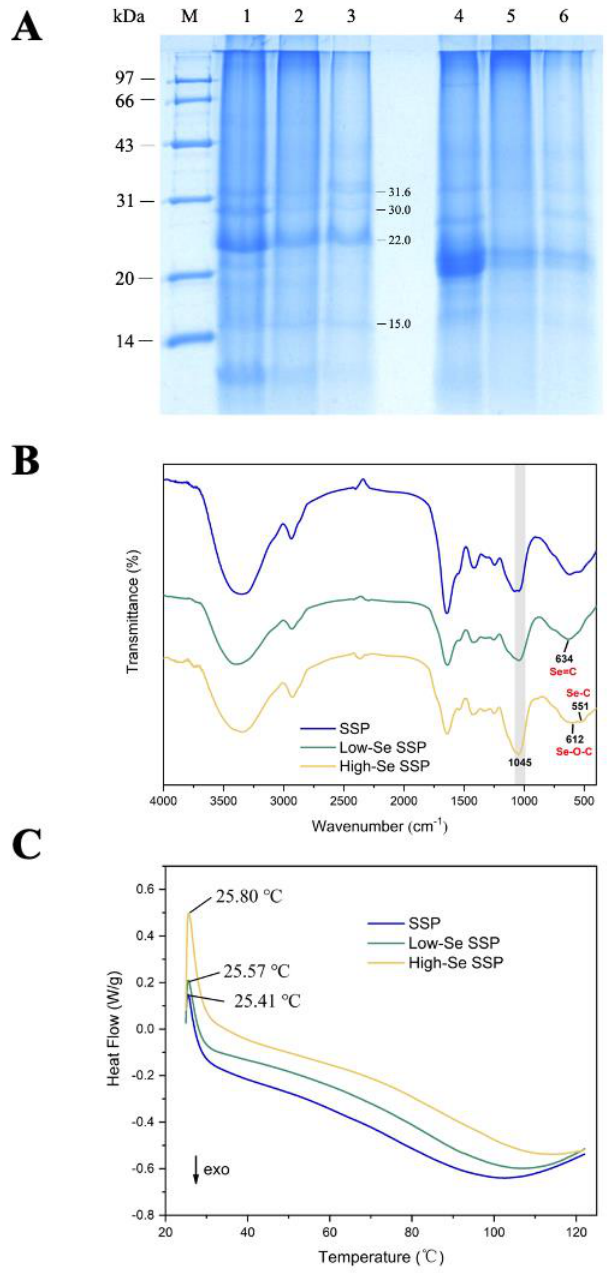
Figure 2. SDS-PAGE analysis ( A ) of SSP (1), low-Se SSP (2) and high-Se SSP (3) under nonreducing conditions and SSP (4), low-Se SSP (5), and high-Se SSP (6) under reducing conditions. M: standard protein markers; FT-IR spectra of SSP samples ( B ); DSC curves of SSP samples ( C